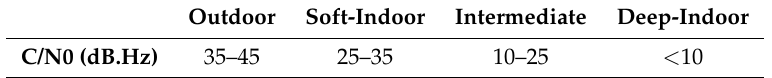
Table 2. Carrier to Noise ratio (C/N0) ranges for different contexts (extracted from